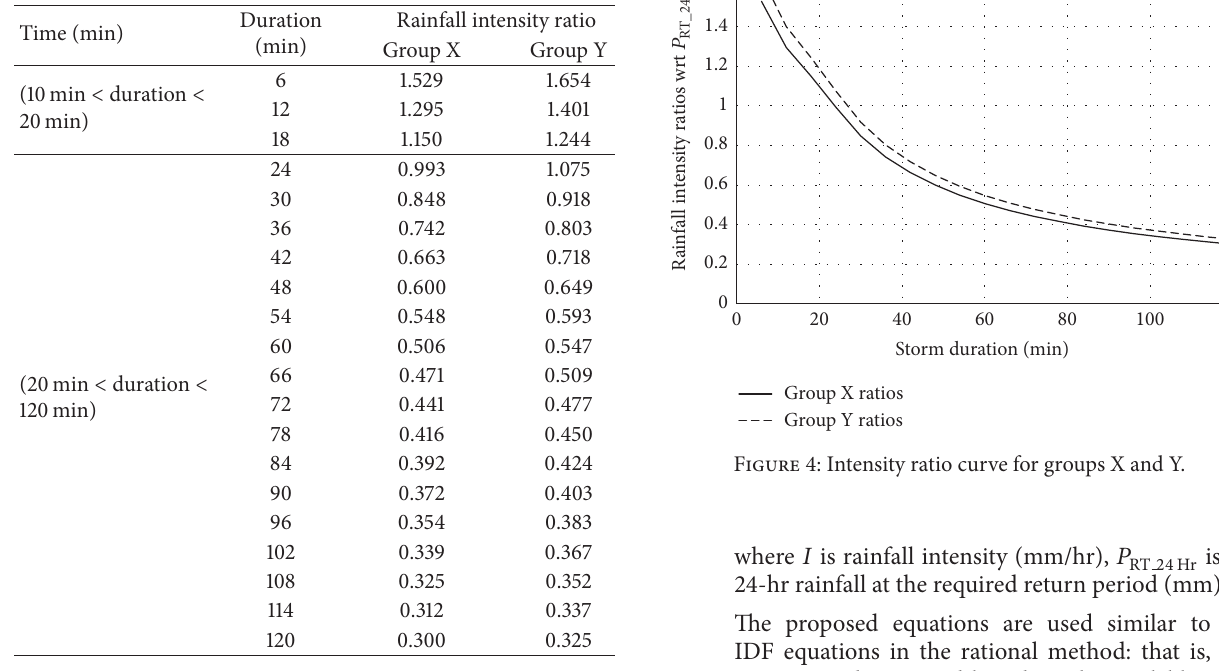
Table 4: Relation between storm duration (min) and rainfall intensity ratios (Groups X and Y).